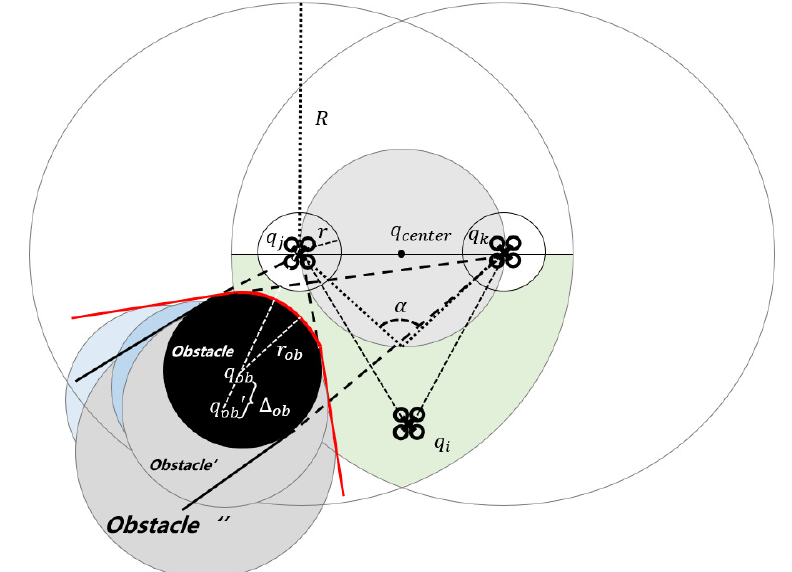
Figure 3. Example of sensing constraints with the FOV α < π and the sensing range R . When robot i lies in the green shaded area, its two neighbors can always be